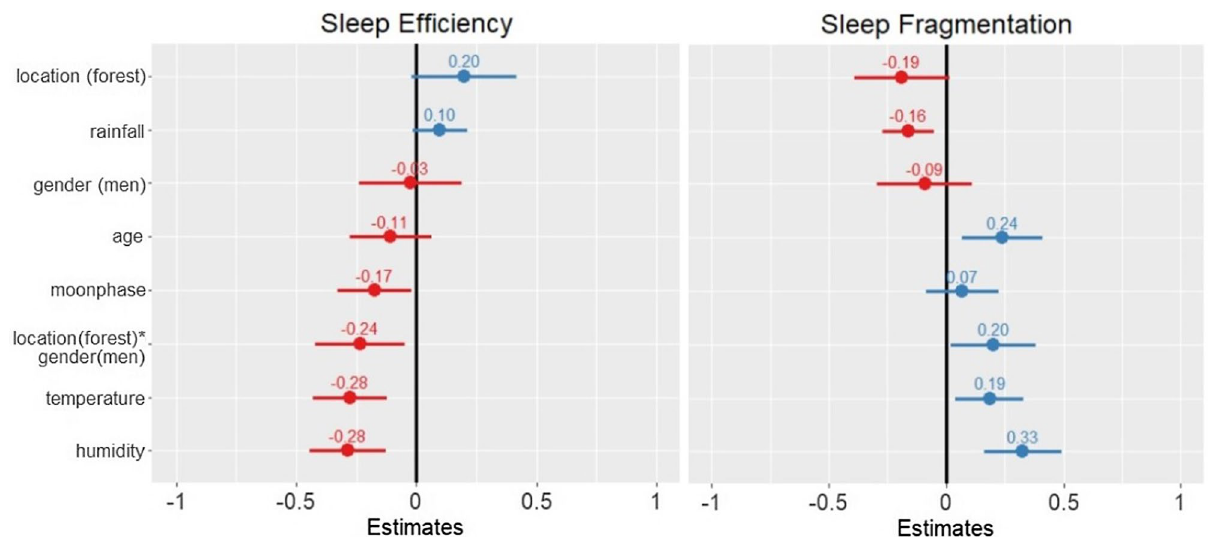
Figure 2. Two fixed effect plots of ecological predictors on sleep quality measures: sleep efficiency (left) and Sleep fragmentation (right). For both plots, positive predictors on sleep quality are indicated in blue, while negative predictors are indicated in red. Values written above each confidence line are standard estimates of each variable. The plot on the left illustrates that humidity, temperature, moon phase, and the location * gender interaction effect all negatively influenced sleep efficiency in the BaYaka. The plot on the right illustrates that rainfall negatively influenced sleep fragmentation, while humidity, temperature, age, and the location * gender interaction effect were positive predictors of sleep